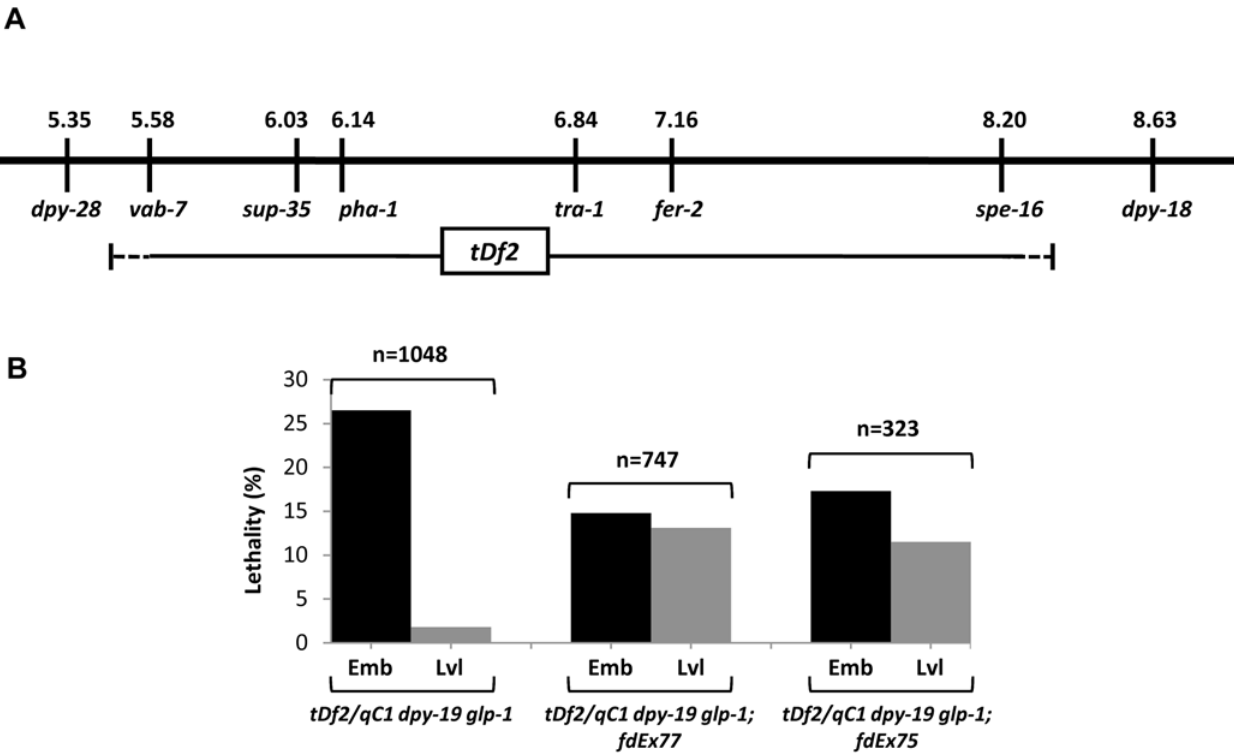
Figure 3. Analysis of a chromosomal deficiency that removes both sup-35 and pha-1 . (A) Genetic map showing extent of the tDf2 deficiency. Although the precise molecular endpoints are unknown, tDf2 minimally extends from vab-7 to spe-16 but does not encompass dpy-28 and dpy-18 . Based on an analysis of genes within the region, tDf2 leads to the deletion of 48 to 74 genes, including sup-35 and pha-1 . (B) Percentage of embryonic- and larval-lethal F1 animals observed for each of the indicated parental genotypes. tDf2/qC1 dpy-19 glp-1 is a balanced strain that segregates 25% tDf2/tDf2 homozygous progeny. fdEx77 and fdEx75 are independently generated extrachromosomalarrays that express wild-type pha-1 andthe sur-5 ::GFP marker. Note that strains carrying the pha-1 -rescuing arrays display a pronounced reduction in the frequency of embryonic lethality along with a concomitant increase in larval lethality. Furthermore, the decrease in embryonic lethality is proportional to the transmission frequencies of the individual arrays; fdEx77 and fdEx75 exhibit transmission frequencies of 50% (n=140) and 39% (n=182), respectively. In addition, for parental strains harboring either the fdEx77 or fdEx75 arrays, . 80% of the observed larval-lethal F1 progeny expressed GFP. Emb, embryos; Lvl, L1 larvae.